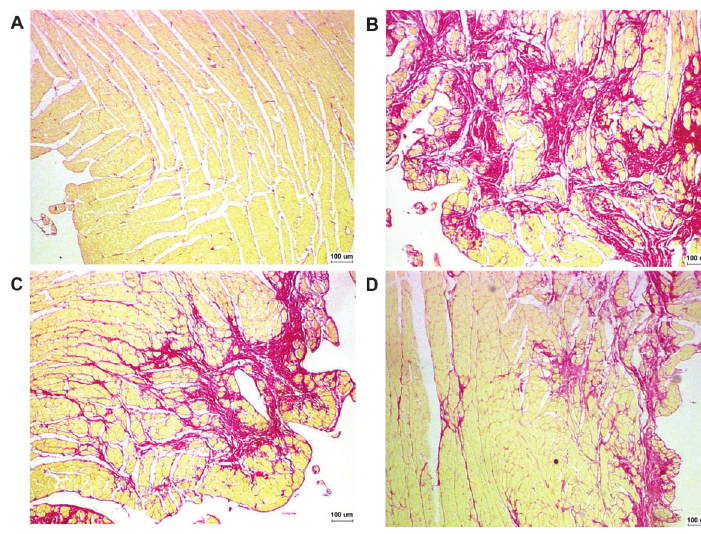
Figure 2. Changes in myocardial fibrosis (picric acid-Sirus red staining). Red indicates collagen fiber and yellow indicates myocardium. A , Control group. B , There was a significant increase